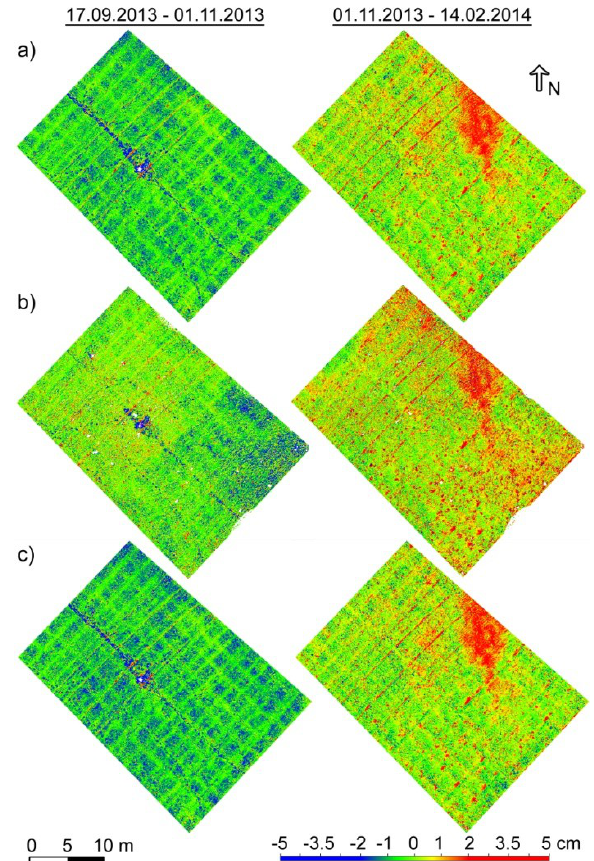
Figure 9: Multi-temporal surface changes. a) only considering UAV data, b) only considering TLS data, c) fused TLS and UAV